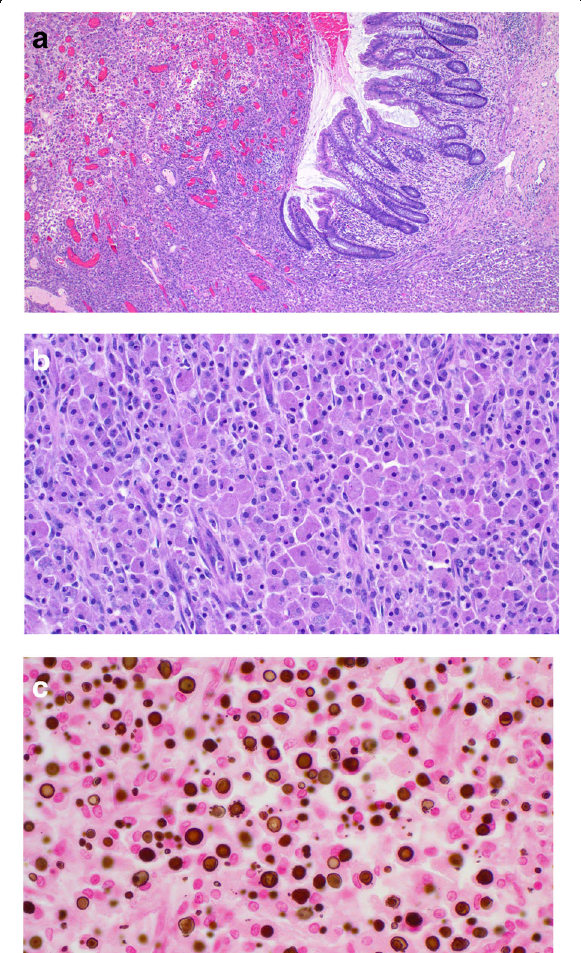
Fig. 3 Microscopy of the resected sigmoid. a Low power image showing ulceration of the mucosa due to massive infiltration of all levels of the bowel wall by malakoplakia. b Medium power image of the sheet-like infiltrate of large non-atypical macrophages with abundant granular cytoplasm. c High power image of abundant MG bodies. They are of variable size with a round to ovoid shape. Many have a targetoid